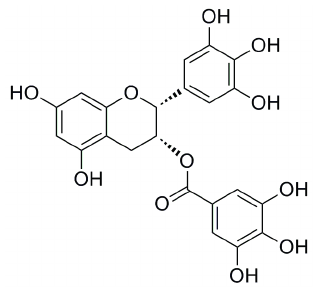
Figure 1. Chemical structure of epigallocatechin-3-gallate (EGCG).